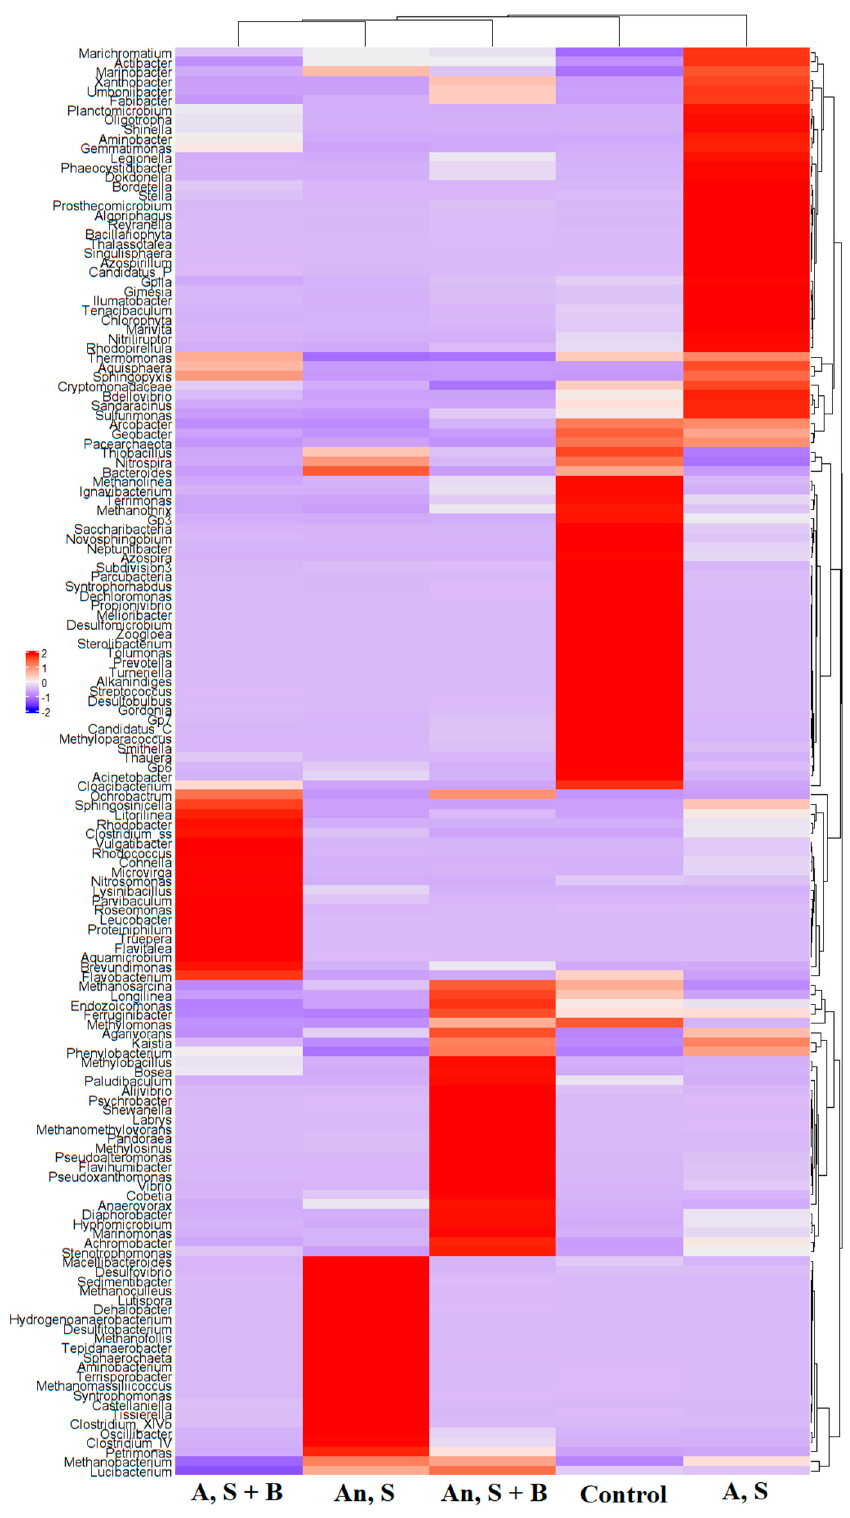
Figure 6. Major microbial communities (genus level) in sludge after the 3rd repeated addition experiment. Control: original sludge. A, S: aerobic conditions, sludge only. A, S + B: aerobic conditions, sludge + bacteria. An, S: anaerobic conditions, sludge only. An, S + B: anaerobic conditions, sludge + bacteria. The major microbial genera (red color in heatmap) under the five experimental conditions are listed in Table S2.